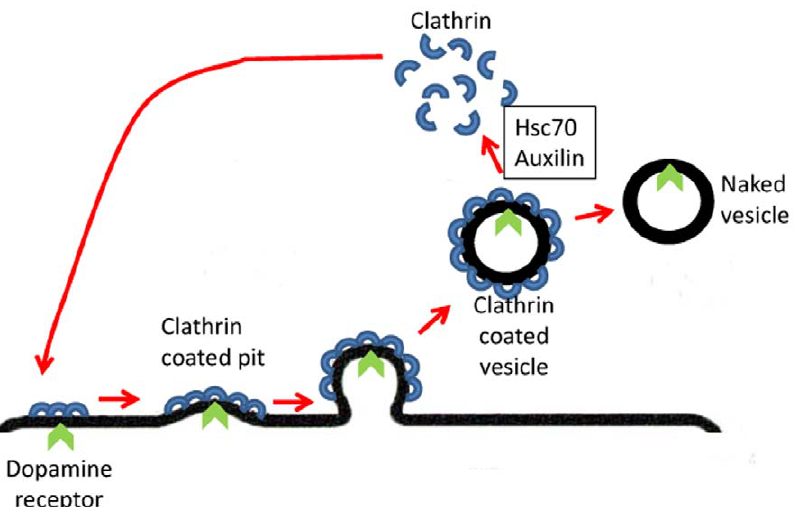
Figure 2. Schematic representation of clathrin-mediated endocytosis. Plasma membrane molecules (in this case the dopamine receptor) associate with nascent clathrin-coated pits which then mature invaginate and finally pinch off to form clathrin-coated vesicles. The shedding of the coat takes place after the vesicle buds from the plasma membrane. This process is driven by Hsc70 ATP hydrolysis activity which is recruited to clathrin coats by Auxilin. The uncoated vesicle fuses with the membrane of a target compartment and delivers its cargo. Clathrin molecules are directed to the plasma membrane for re-use.